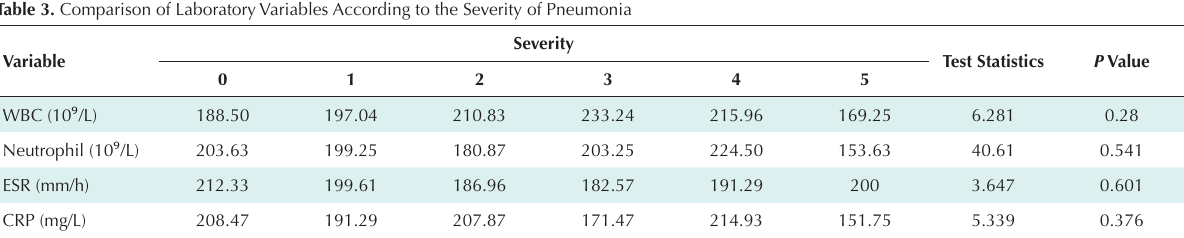
Table 3. Comparison of Laboratory Variables According to the Severity of Pneumonia Variable